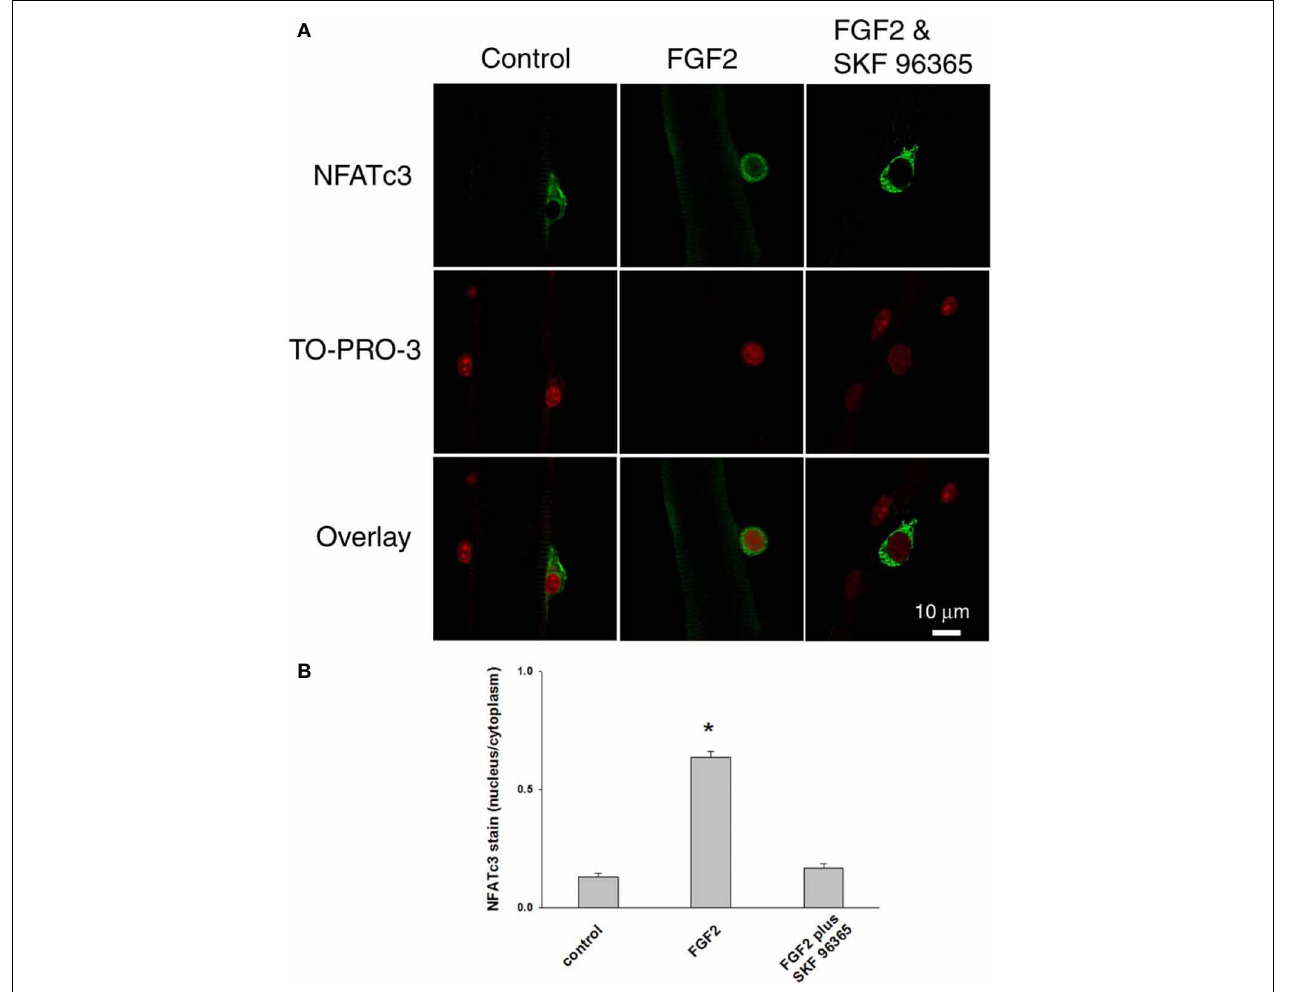
FIGURE 7 | Documenting NFATc3 activation by imaging NFATc3 translocation. NFATc3 is located in the cytoplasm and not in the nucleus in quiescent satellite cells in the absence of FGF2 in ( A,B ; left column). In FGF2 treated satellite cells, NFATc3 is located in both cytoplasm and nucleus ( A,B ; middle column). TRPC blocker SKF 96365 antagonized the NFATc3 nuclear translocation triggered by FGF2 ( A,B ; right column).